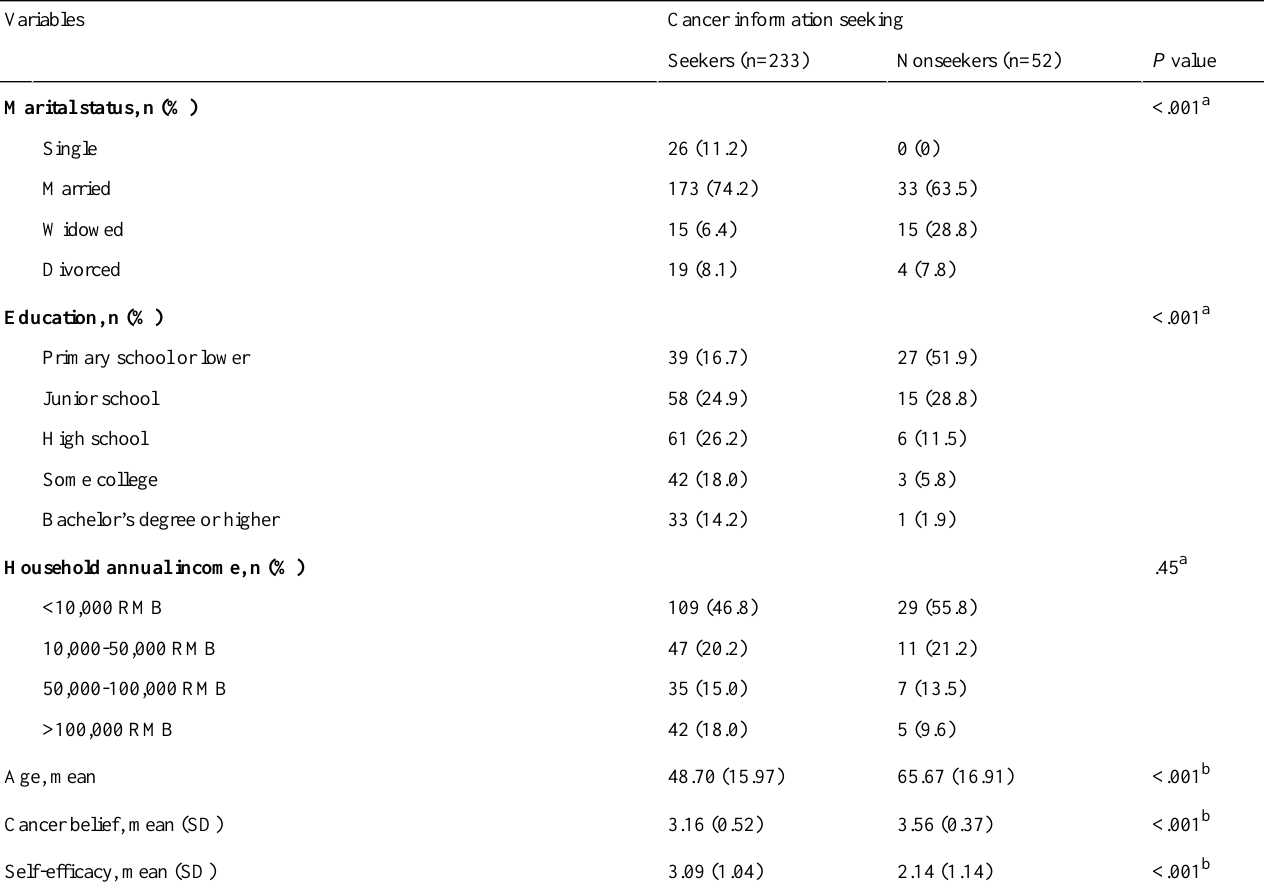
Table 3. Comparison between patients who seek information and those who do not.